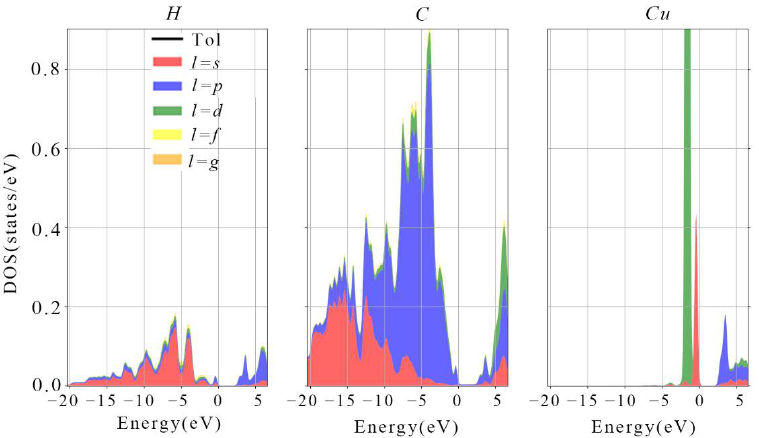
Figure 8. H, C, and Cu atomic DOS map of the copper–diamond interface, 0 points can represent the Fermi level.